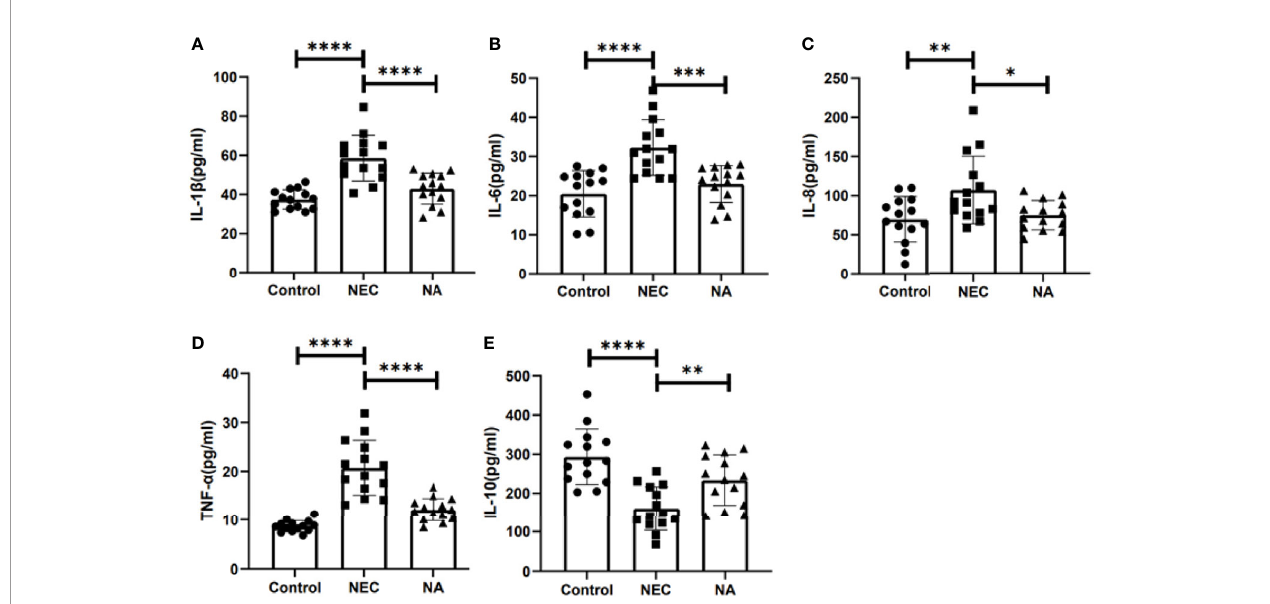
FIGURE 5 | The concentrations of in fl ammatory cytokines in the three groups were detected by ELISA. (A) The concentrations of IL-1 b . (B) The concentrations of IL-6. (C) The concentrations of IL-8. (D) The concentrations of TNF- a . (E) The concentrations of IL-10. Numbers of samples: Con (n=14), NEC (n=14), and NA (n=14). Statistics: one-way ANOVA (*p < 0.05; **p < 0.01; ***p < 0.001; ****p <